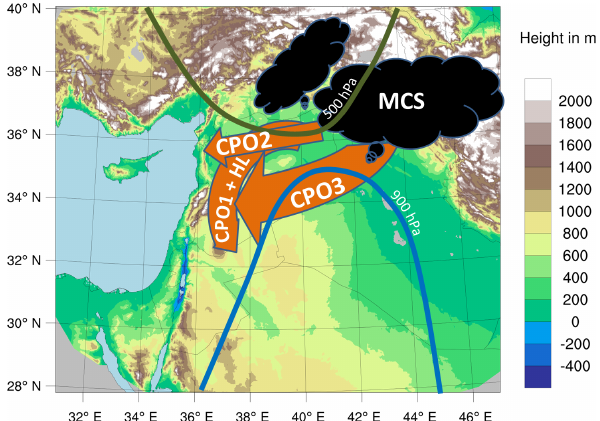
Figure 4. Schematic depiction the main dust event stages and at- mospheric features. The topography as used by the finest domain is colour-coded. Coloured lines represent average geopotential height of pressure levels. Labels refer to the description used in the text. Arrow size corresponds to event magnitude and arrowhead size to event